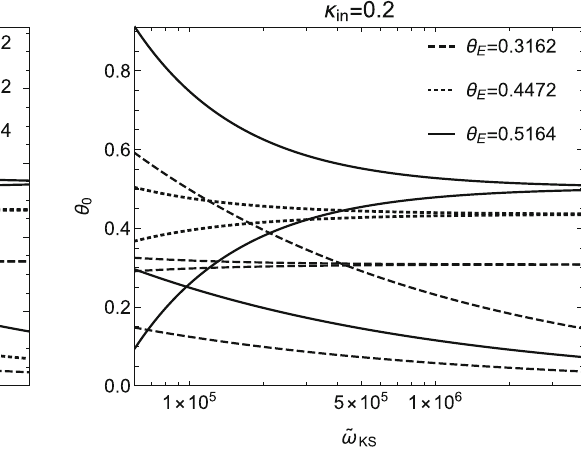
Fig. 8 Ontheleftpanel,weshowthedependenceofEinsteinangle( θ 0 ) for homogeneous distribution of plasma with dimensionless “Hoˇrava parameter” ( ω ) for different values of θ E : 0.5164 (solid line), KS 0.4472 (dashed line), 0.3162 (dotted line). On the right panel, we show